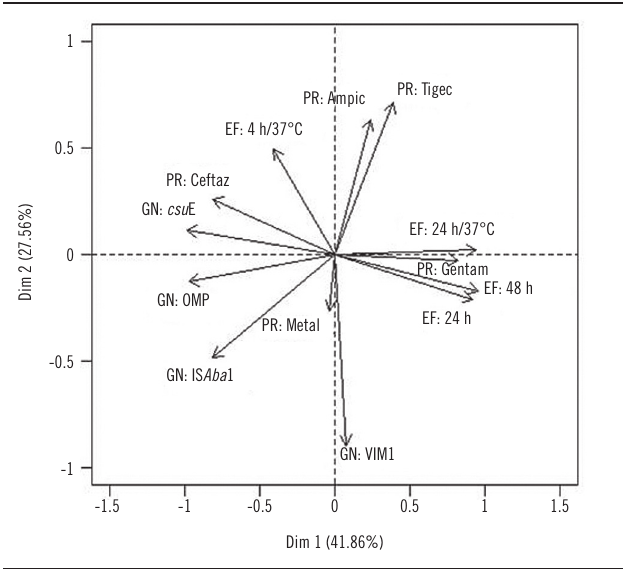
figurE 1 − Perceptual map via the main components for the variables